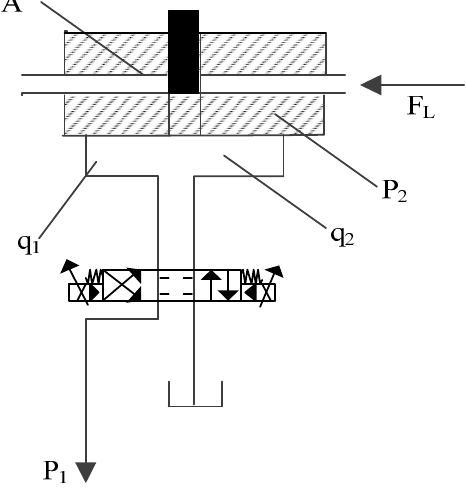
Figure 3. Symmetrical, simplified model of the hydraulic-valve throttle.